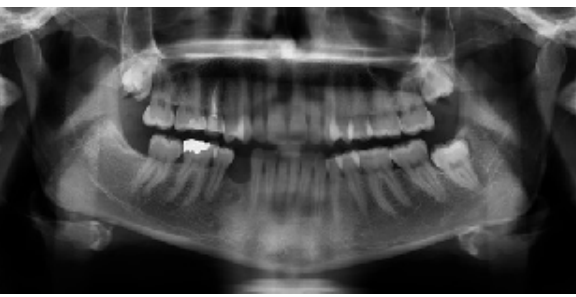
Figure 3: Panoramic radiograph of the patient 54 months after treatments In contrast, the extrafollicular AOT cases